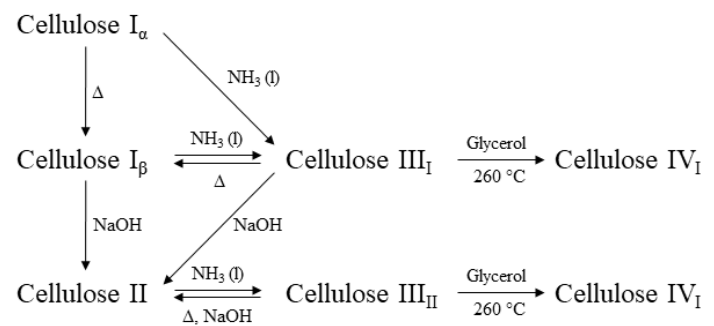
Figure 13. Cellulose polymorphs and their conversion, redrawn from [118], with permission from Springer, 2008.